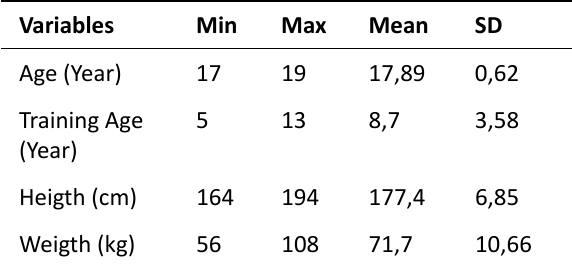
Table 1. Basic demographic characteristics of